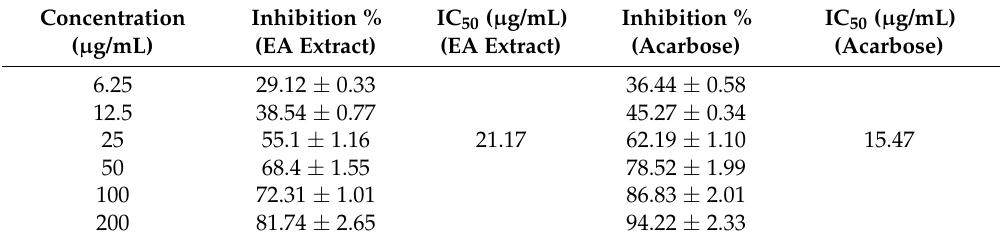
Table 3. α -glucosidase inhibition and IC 50 values of ethyl acetate extract of Streptomyces sp.S2A. Concentration